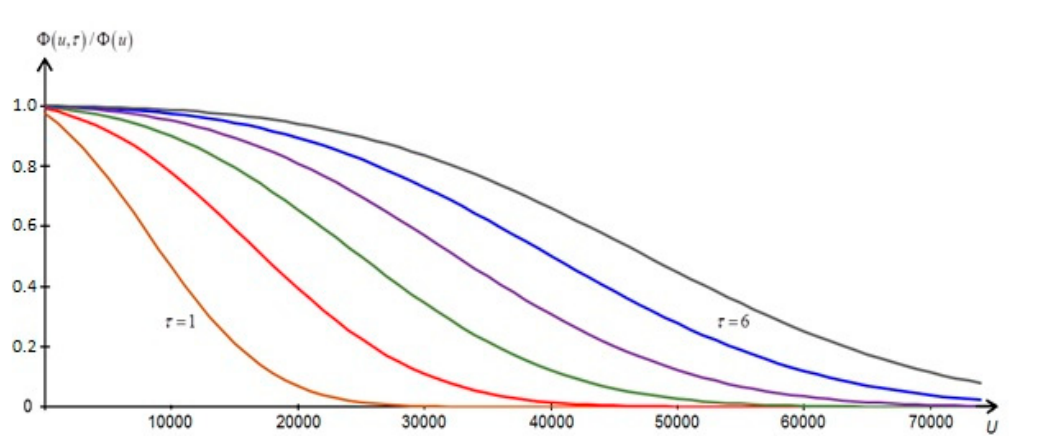
Figure 4. At times τ = 1, 2, . . . ,6 the ruin probability falls as the reserves increase and for a particular level of reserves the ruin probability increases with time.